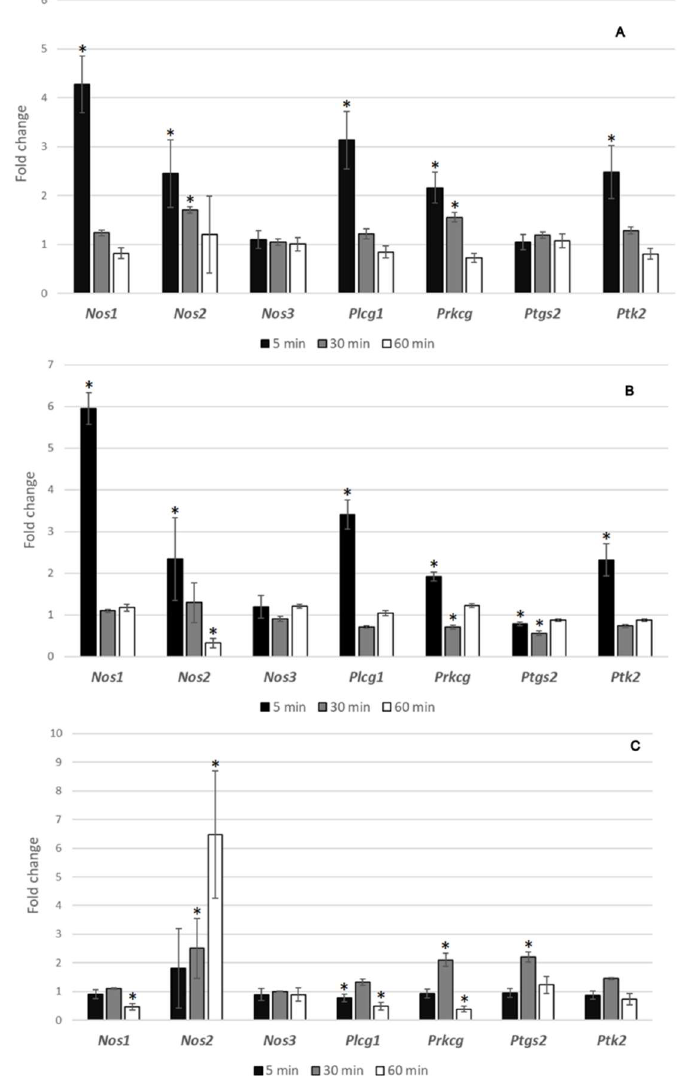
Figure 11. Fold changes in mRNA levels in rat brain samples ( A – C ). Healthy rats. ( A ) BPC 157 (10 ng/kg ip) application vs. saline (5 mL/kg ip) application (control); ( B ) Ketamine (30 mg/kg ip) application vs. saline (5 mL/kg ip) application (control); ( C ) Ketamine (30 mg/kg ip)+BPC 157 (10 ng/kg ip) vs. ketamine (30 mg/kg ip)+saline (5 mL/kg ip) (control). Selected genes were tested in three-time intervals: 5, 30 and 60 min. Results are expressed as fold changes: mean ± SD, * marks significant value ( p ≤ 0.05). Fold change values < 1.00 indicate decreased gene expression in treated animals (downregulation), and fold change values > 1.00 indicate increased gene expression in treated animals